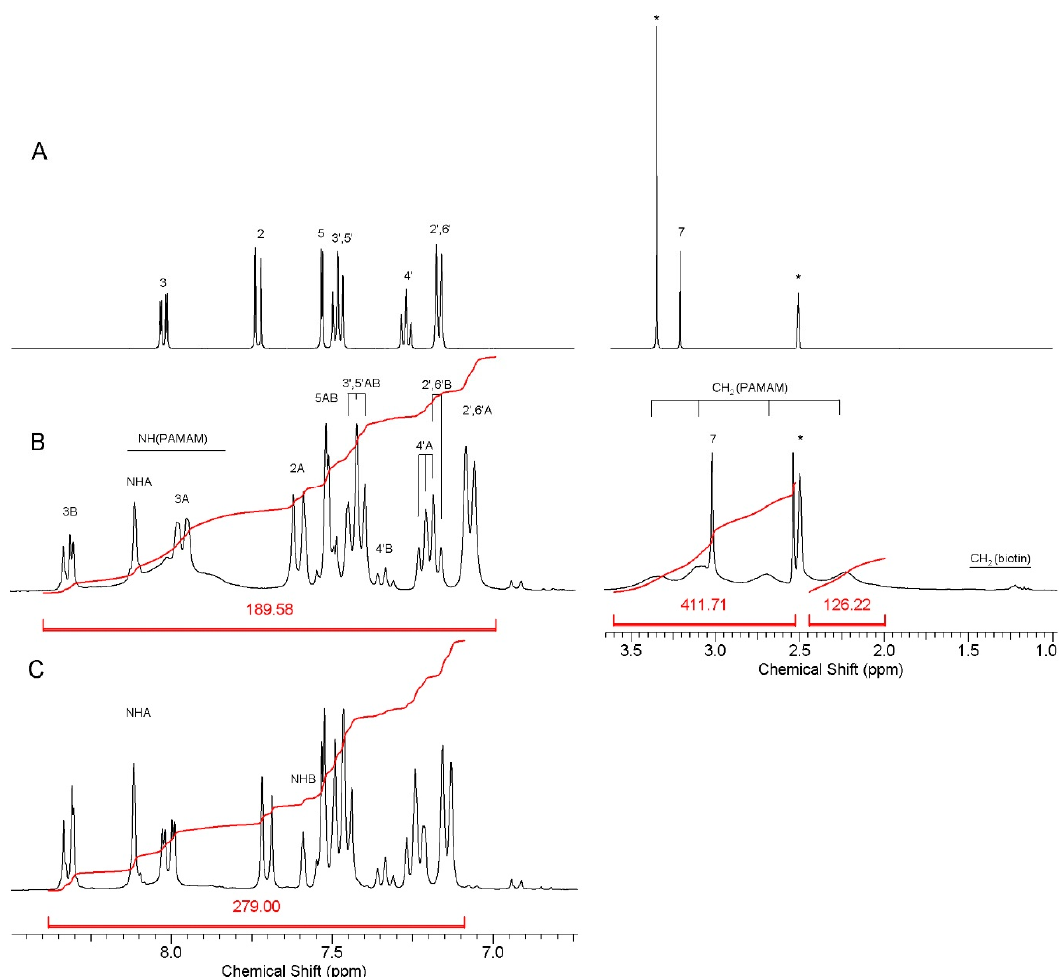
Figure 1. Relevant regions of 1 H NMR spectra in dmso- d 6 of: A—nimesulide, B—G3 B18N , C—G3 B31N . For numbering of N resonances, see Scheme 1. The N resonances of two isomers of carbonate amide linked N were combined into A and B sets due to scalar coupling observed in the 1 H- 1 H COSY experiment performed for G3 B31N . Amide linker NH proton resonances were identified by selective deuteration with D 2 O. Residual water and solvent resonances are labeled with asterisks. The intensity of resonances was divided by factor of four at the right side of spectrum B in order to fit the spectrum in window. For atom numbering of N, see Scheme 1. The residual H DO and CD 2 H SOCD 3 resonances are labeled with asterisks.